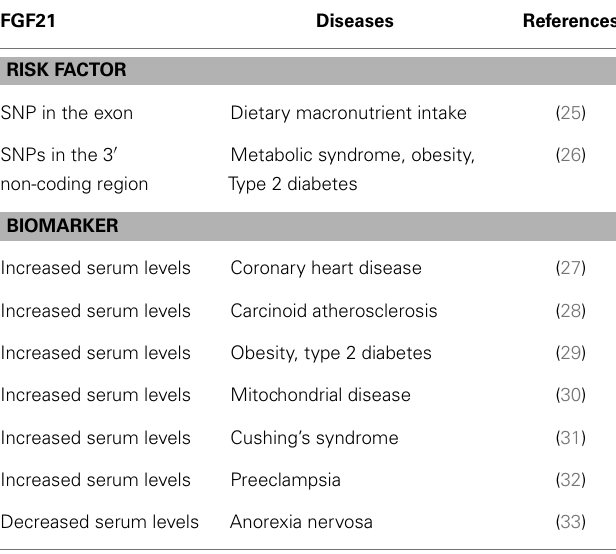
Table 2 | FGF21 as a risk factor for and biomarker of diseases